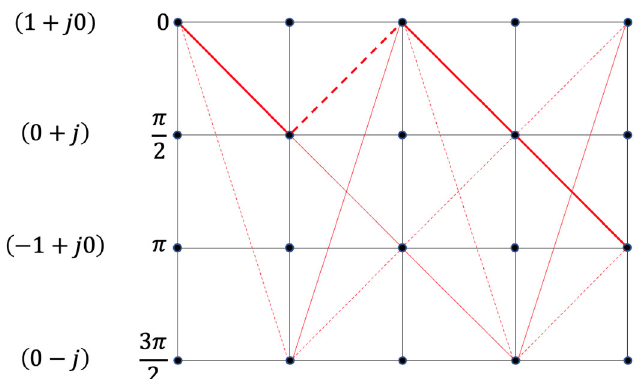
Figure 4. All the possible paths through the trellis for h = 1/2. Solid lines indicate bit 1, broken lines indicate bit 0, and bold lines indicate a typical bit sequence of 1011. The complex numbers beside the figure are the possible CPM mapper output.